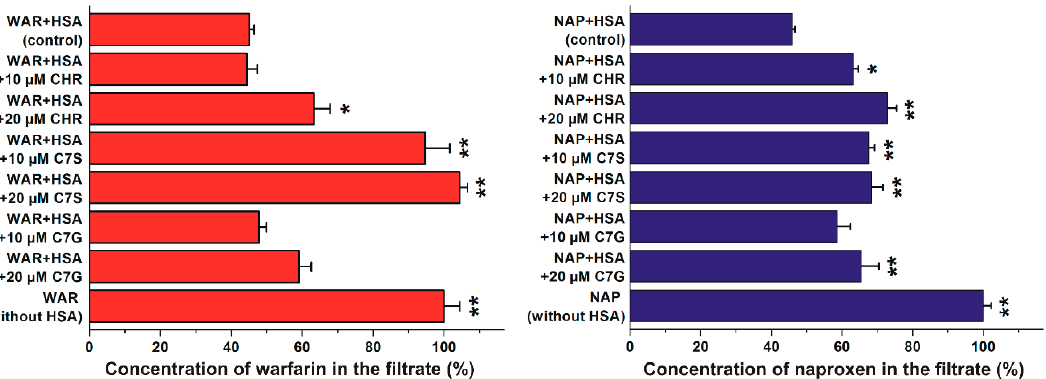
Figure 4. Concentrations of warfarin (left) and naproxen (right) in the filtrate. Left: Before ultrafiltration, samples contained 1 µmol/L warfarin (WAR) with 5 µmol/L HSA in the absence and presence of 10 or 20 µM flavonoid concentrations in PBS (pH 7.4). Right: Before ultrafiltration, samples contained 1 µmol/L naproxen (NAP) with 1.7 µmol/L HSA in the absence and presence of 10 or 20 µM flavonoid concentrations in PBS (pH 7.4). (* p < 0.05, * * p < 0.01; CHR: chrysin; C7S: chrysin-7-sulfate; C7G: chrysin-7 glucuronide).